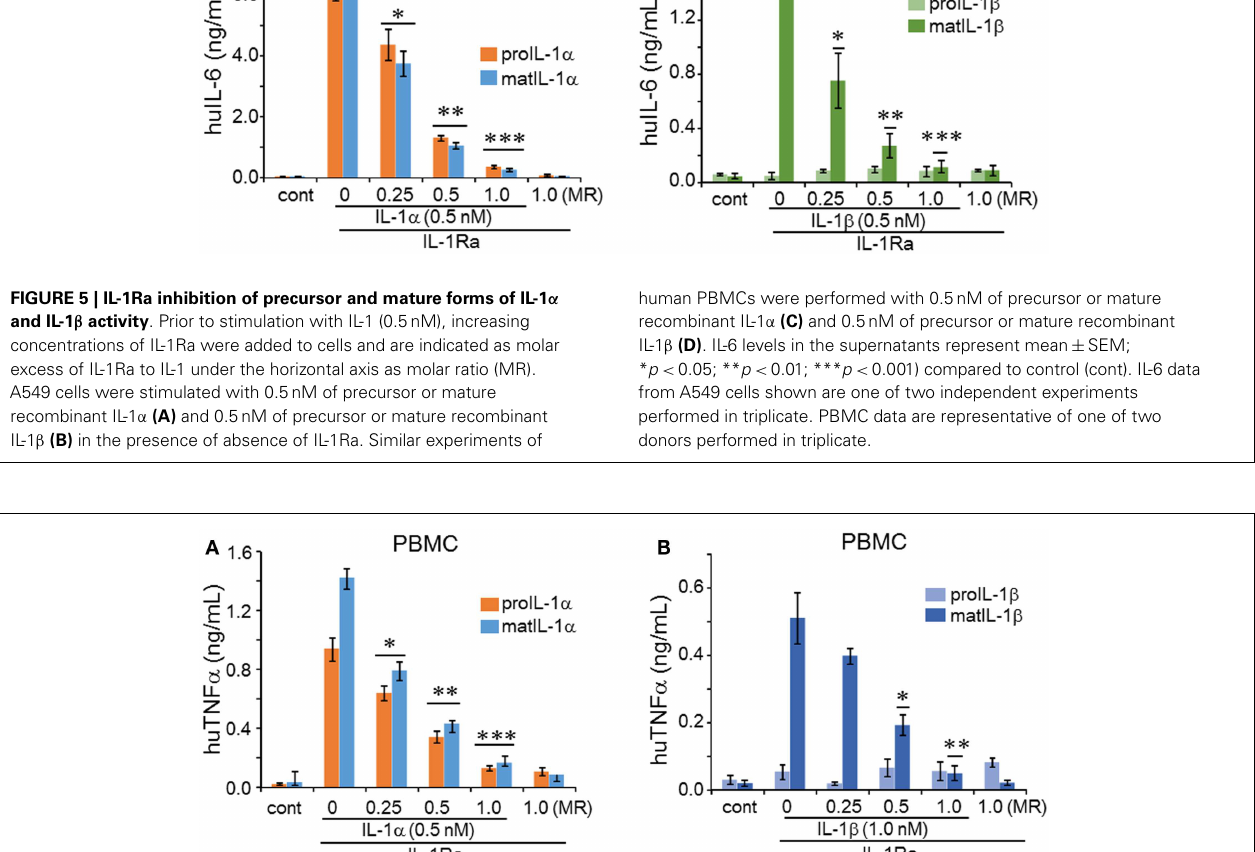
FIGURE 6 | Inhibition of IL-1 α or IL-1 β inducedTNF α by IL-1Ra . Prior to stimulation with IL-1 α or IL-1 β , increasing concentrations of IL-1Ra were added to cells indicated as molar excess of IL-1Ra to IL-1 under the horizontal axis as molar ratio (MR). PBMC cells were stimulated with 0.5nM of precursor or